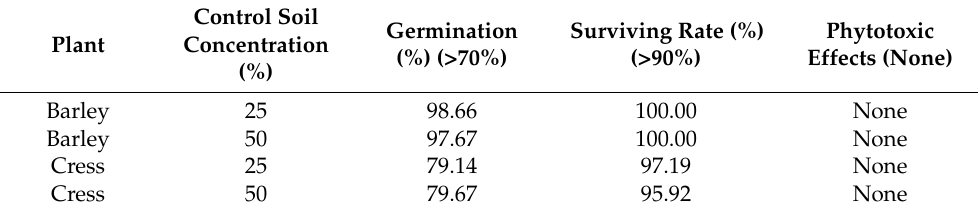
Table 22. Validity criteria of germinated plants and fresh biomass (with control